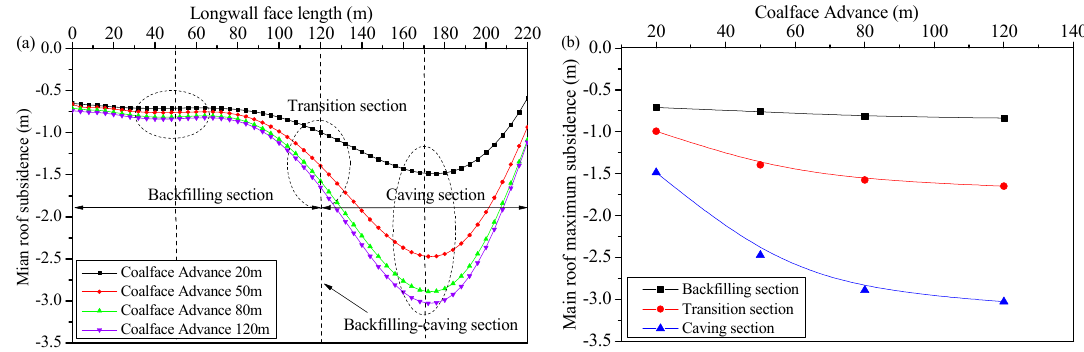
Figure 12. Characteristics of strata movement in the transition section: ( a ) main roof subsidence; ( b ) maximum subsidence of main roof.